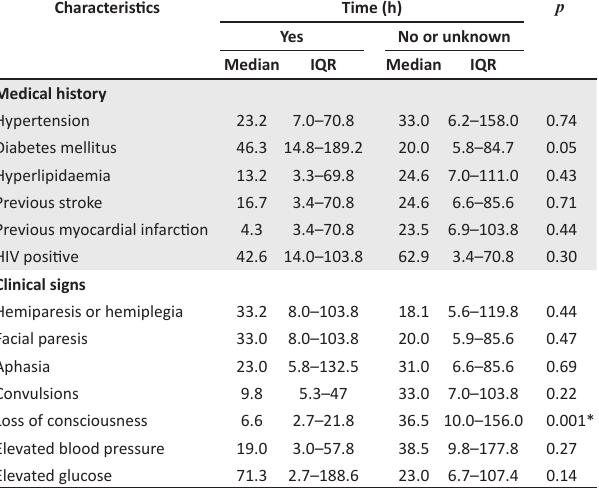
TABLE 3: Comparison of times to emergency department presentation by medical history and clinical signs.